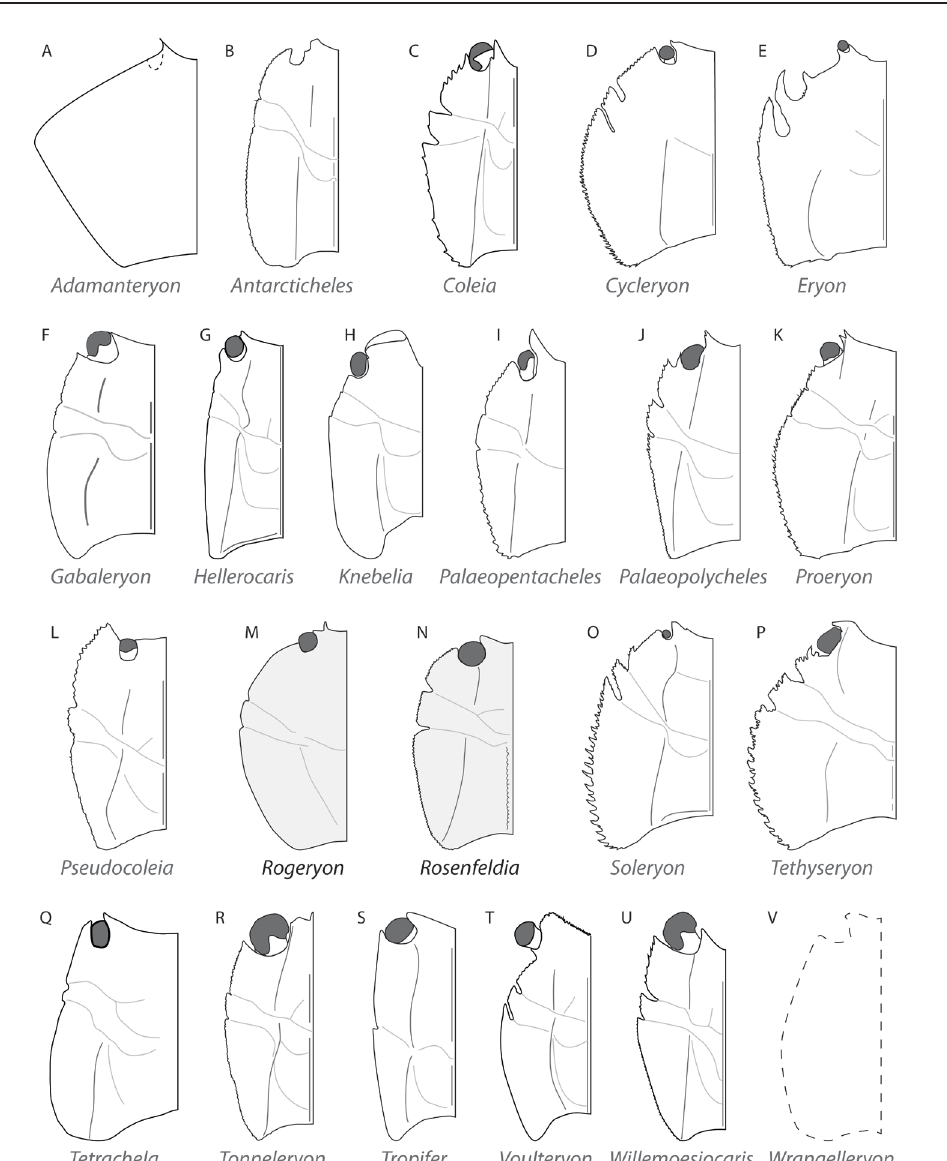
Fig. 2. Comparison of the general outline of carapaces (right sides omitted, adapted from Audo 2016 and Audo et al . 2017) of the type species of each genus of fossil Polychelida. A . Adamanteryon